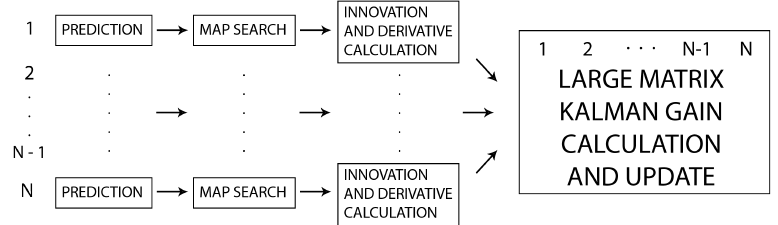
Figure 5. Parallel